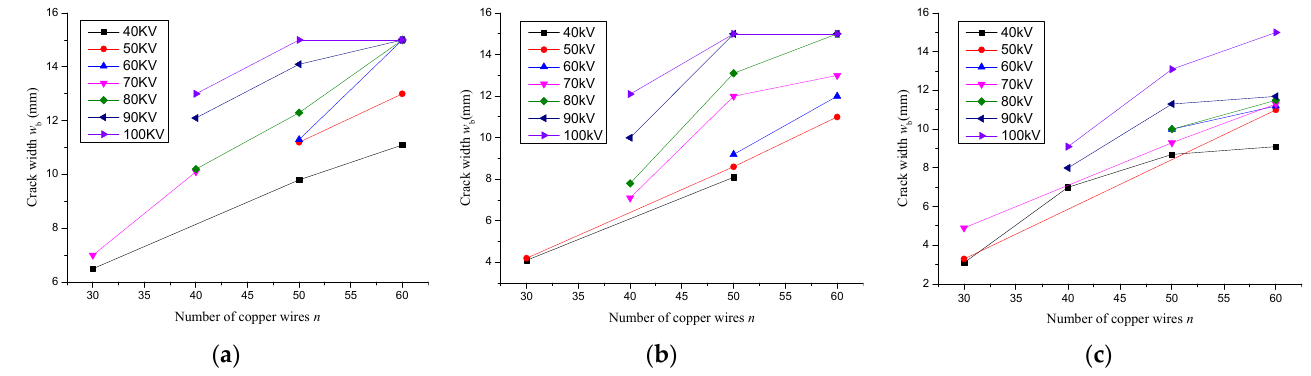
Figure 12. Relationship between crack width w b and number of copper wires n . ( a ) Concrete C20; ( b ) Concrete C30; ( c ) Concrete C40.